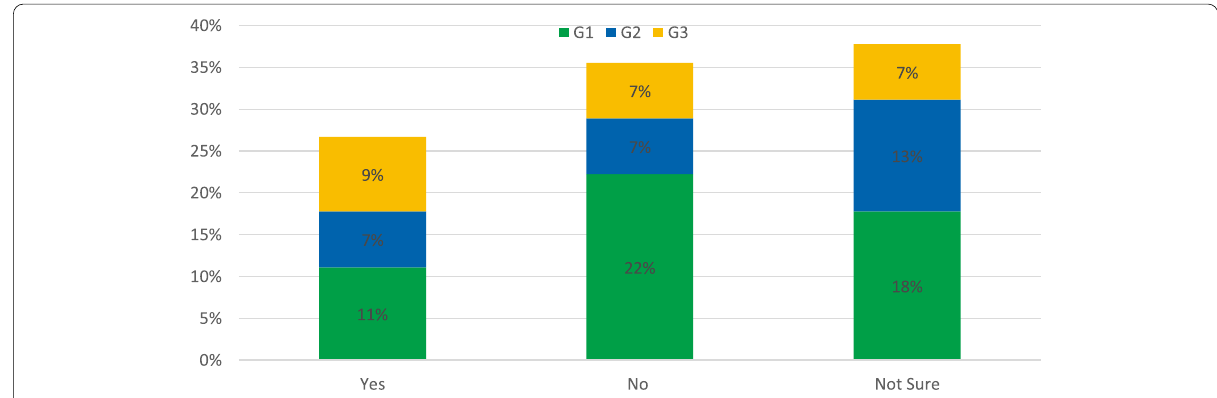
Fig. 3 Response to: Do you think parts of the road network could be un‑adopted, repurposed or privatized as a feasible